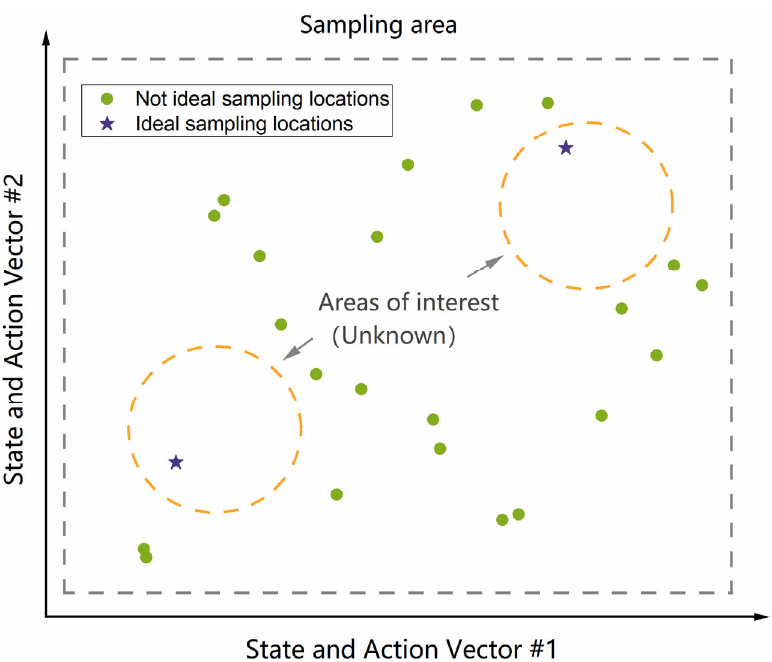
Figure 4. Schematic diagram of ideal sampling. Ideally, it is only necessary to sample near the equilibrium point under two con fl icting states for each design.